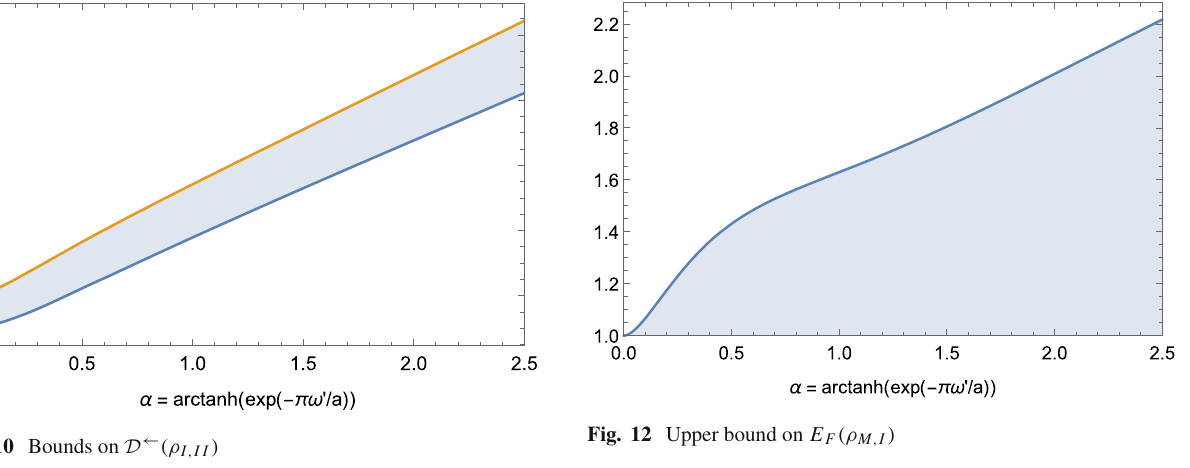
Fig. 10 Bounds on D ← (ρ I , II )